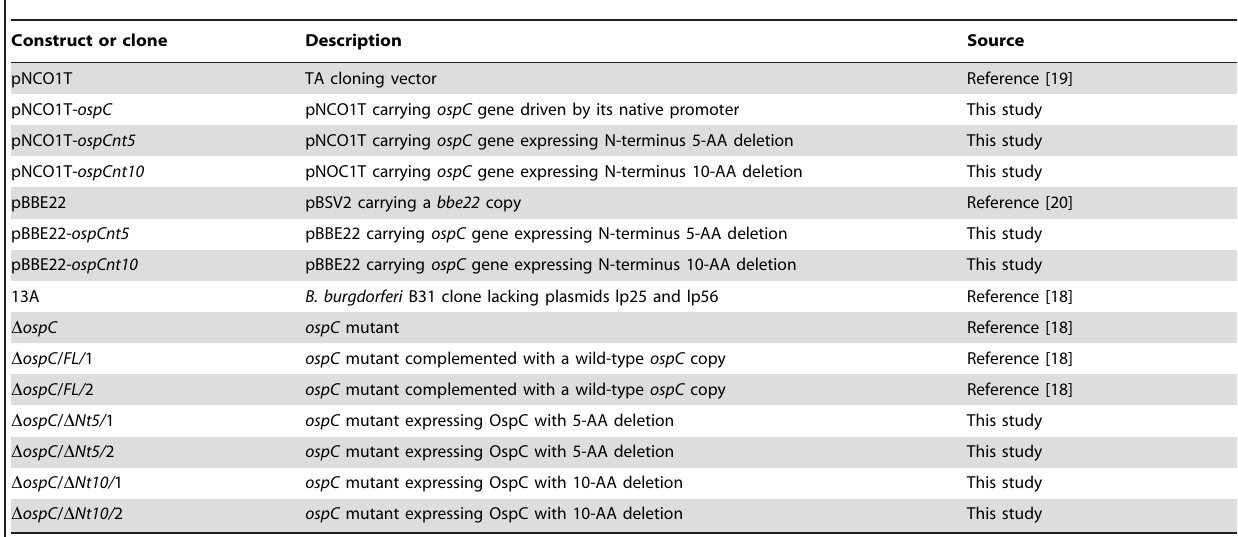
Table 1. Constructs and clones used in the